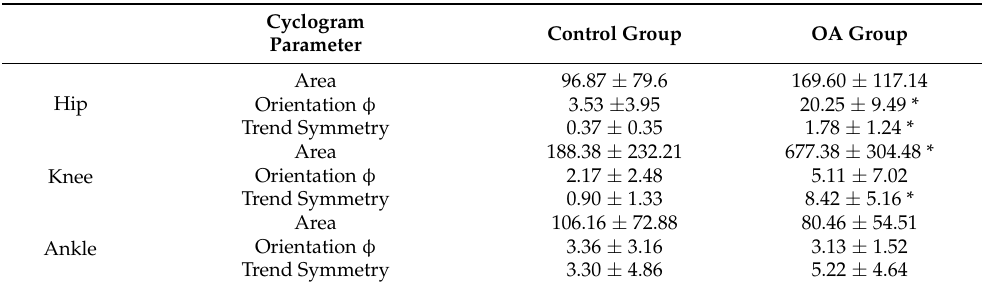
Table 5. Comparison between symmetry indexes of people with hip OA and unaffected individuals. Values are expressed as mean ±